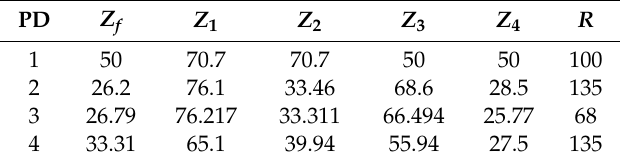
Table 1. Power divider branches impedances (optimization values).